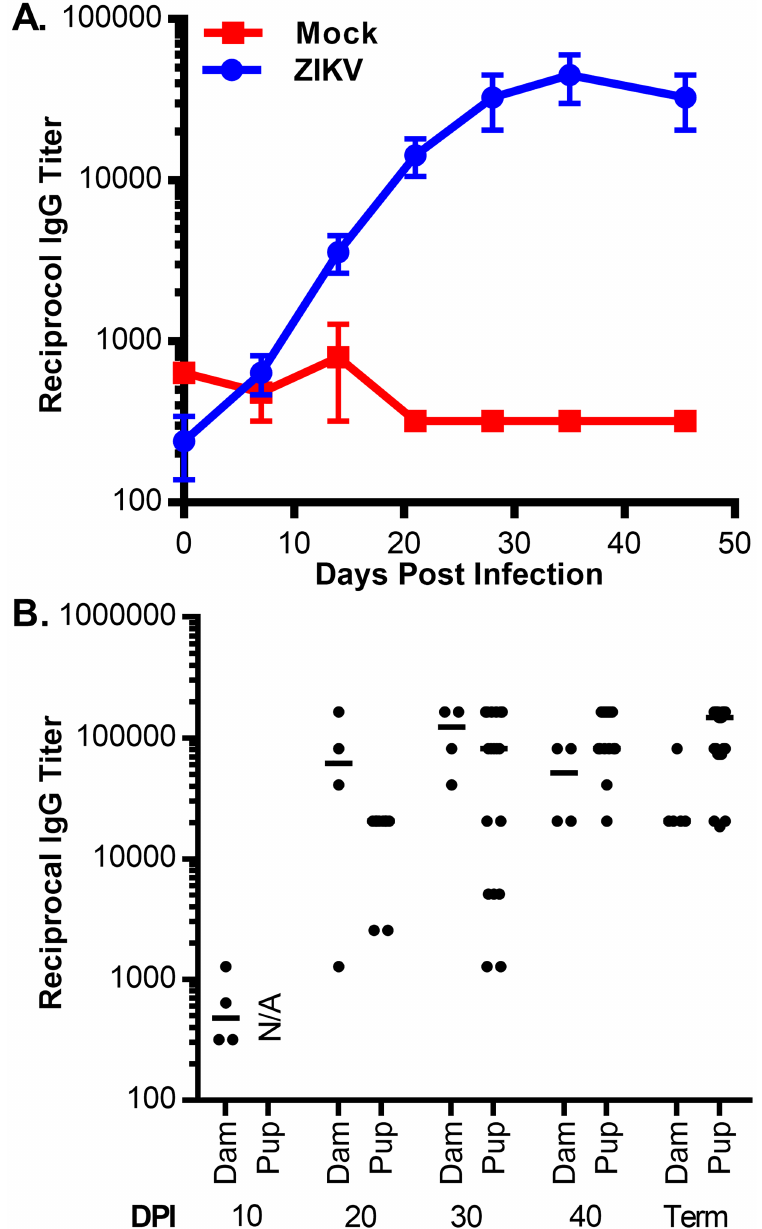
Fig 5. Evolution of the anti-NS1 response in pregnant dams. The IgG responseto ZIKV NS1 of pregnant guineapigs and their pups was measuredby ELISA. (A) The mean anti-NS1 titer of pregnantguineapigs challenged with ZIKV (N = 5) or sham injected(N = 2) was measuredover time and plotted; bars indicate the standarderror for each time point. (B) The anti-NS1titers of pregnantdams and pups were measuredat each experimental endpoint.The bars indicatethe mean antibody titer at each time